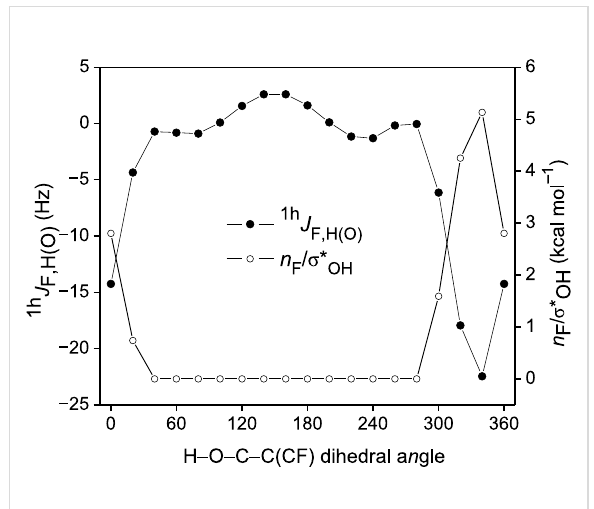
Figure 4: Angular dependence of 1h J F,H(O) and n F →σ * OH interaction in 5 . 1h J F,H(O) SSCC (Figure 4), which is governed by the Fermi contact term. The SSCC amplitudes upon varying θ for the remaining diastereoisomers, are negligible (see Supporting Information File 1), as is the n F →σ * OH interaction, as expected; on the other hand, the calculated 1h J F,H(O) SSCC for the global minimum is significant (ca. − 18 Hz, Table 3).